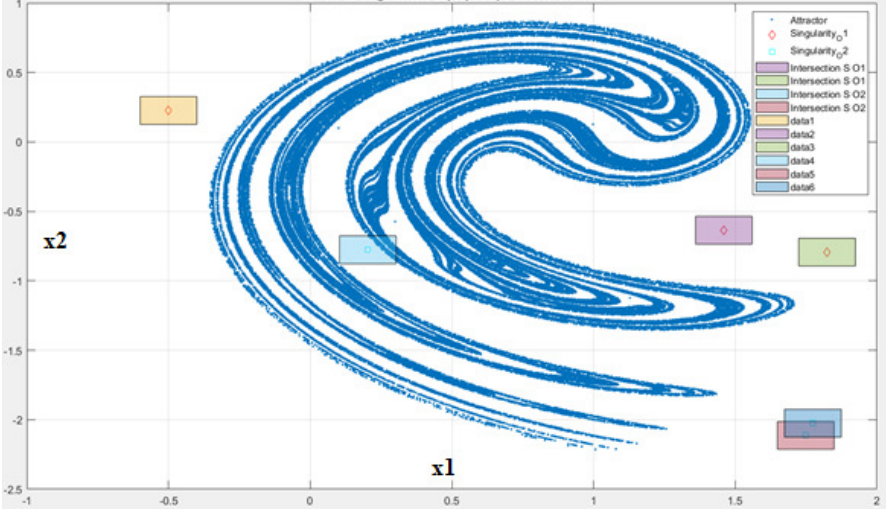
Figure 5. Singularity areas for the Ikeda